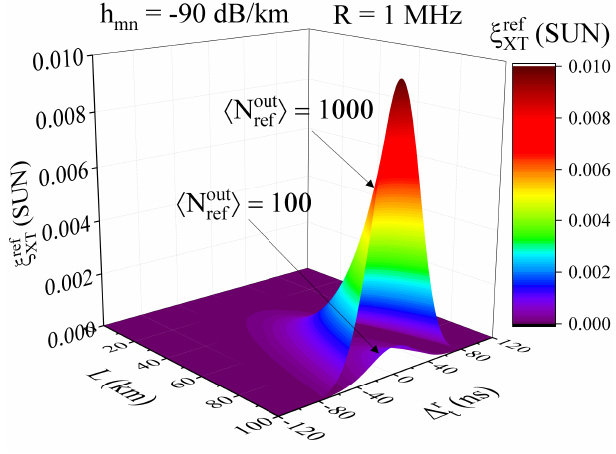
Figure 2. The excess noise contributed from the weak reference pulse as a function of the transmission distance and ∆ r . SUN, shot noise t